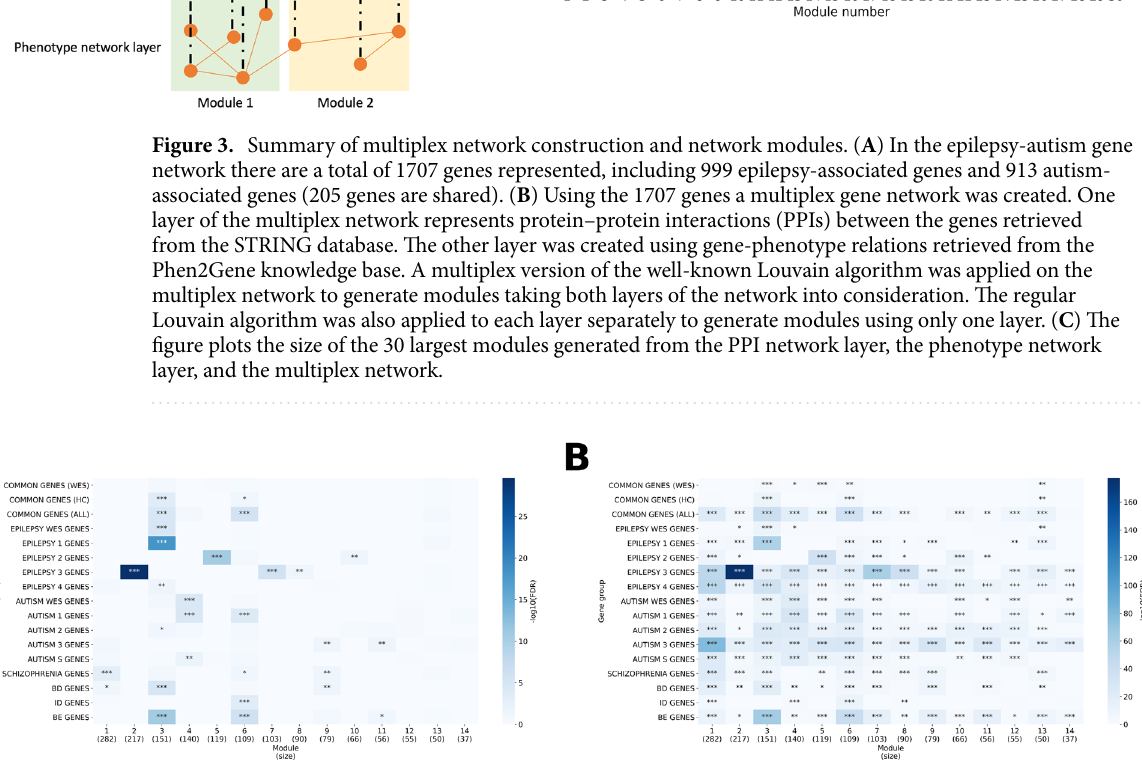
Figure 4. Gene enrichment analysis on modules in the epilepsy-autism multiplex network. The enrichment analysis of different gene groups over the 14 largest modules in the epilepsy-autism multiplex network. The hypergeometric test was used to determine the p-value and the false discovery rate (FDR) is reported since multiple gene groups were tested. ( A ) The background of the hypergeometric test is the 1707 genes in the network. ( B ) The background of the hypergeometric test is 19,556 genes (the number of genes in the STRING database). COMMON GENES (WES) = genes in both the epilepsy and autism WES gene lists, COMMON GENES (HC) = genes that are both in the epilepsy 1 subgroup and autism 1 subgroup (high confidence), COMMON GENES (ALL) = all genes in both epilepsy subgroup and autism subgroup, BD = bipolar disorder, ID = intellectual disability, BE GENES = genes that have significantly higher expression in brain tissue vs control tissue. For both A) and B), “***” denotes FDR < 0.01, “**” denotes FDR < 0.05, and “*” denotes FDR < 0.1, assuming a hypergeometric distribution. The heatmap was generated using seaborn version 0.10.0 (https ://seabo rn.pydat Additional details on the classification of these subgroups are given in Table 1. The distribution of these subgroups within the 14 largest multiplex modules are shown in Fig. S2. We found that certain modules are enriched in spe- cific subgroups of epilepsy genes (Fig. 4). Module 3, which represents the GO biological process of ion transmem- brane transport as discussed previously, is enriched in Epilepsy 1 genes (genes directly causing epilepsy) com- pared to other modules (FDR = 7.14e−19). Module 3 is also the only module enriched in whole-exome sequencing (WES) epilepsy genes (FDR = 1.52e−05) and Epilepsy 4 genes (FDR = 0.0270) (predicted epilepsy genes) relative to other modules. Modules 5 and 10 are enriched in Epilepsy 2 genes (neurodevelopment-associated genes)